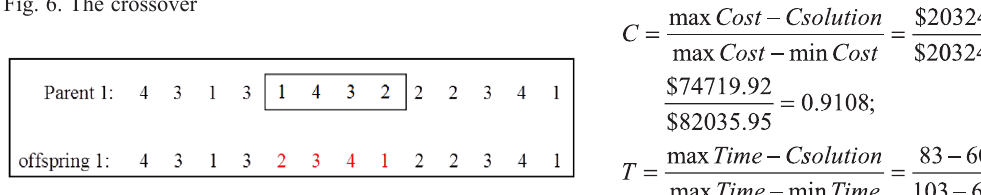
Fig. 7. The inversion